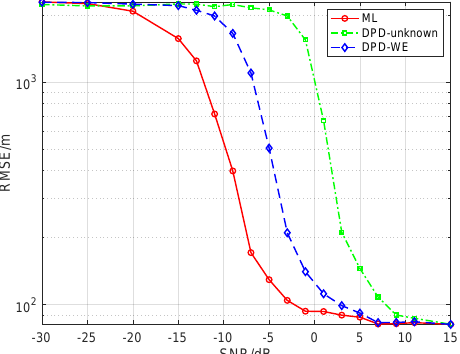
Figure 8. RMSE vs. SNR for the three localization algorithms of ML, DPD-unknown and DPD-WE with transmitting single Gaussian pulse.